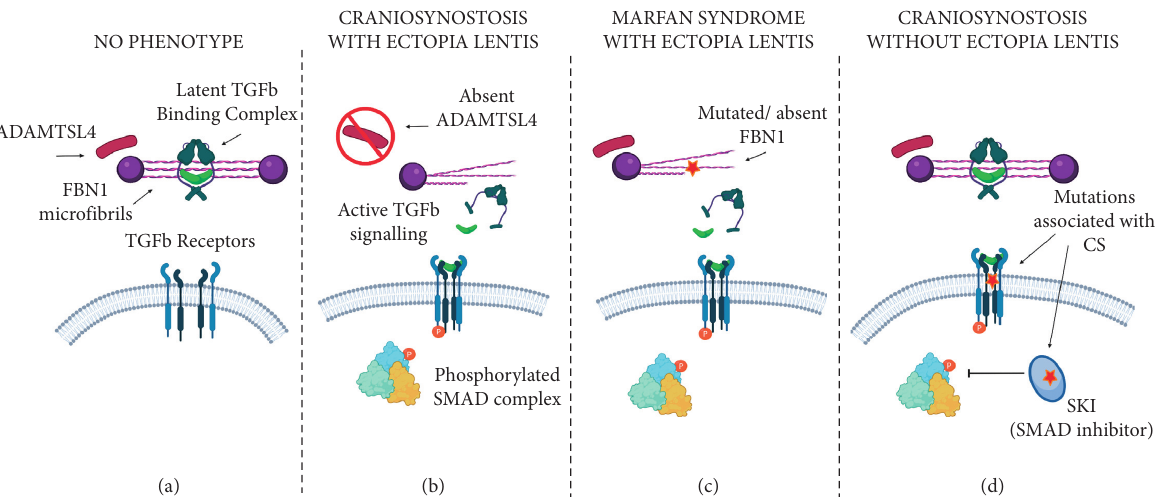
Figure 2: Schematic of proposed molecular mechanism of craniosynostosis and ectopia lentis phenotypes associated with ADAMTSL4, FBN1, and the TGFb pathway. (a) ADAMTSL4 is present and FBN1 is intact, TGFb ligand is tethered to fibrillin microfibrils, and the TGFb pathway is inactive. This does not cause a dysmorphic phenotype. (b) ADAMTSL4 is absent, fibrillin microfibrils are disintegrated leading to ectopia lentis, TGFb ligand is inappropriately released from extracellular matrix and binds TGFb receptors, and the TGFb pathway is aberrantly activated resulting in craniosynostosis. (c) ADAMTSL4 is present, but FBN1 is mutated, fibrillin microfibrils are disintegrated, TGFb ligand is inappropriately released from extracellular matrix and binds TGFb receptors, and the TGFb pathway is aberrantly activated resulting in Marfan syndrome with ectopia lentis. (d) ADAMTSL4 is present and fibrillin microfibrils are intact. Activating mutations in TGFb receptors and downstream modulators of the TGFb pathway cause aberrant signaling resulting in syndromic craniosynostosis (LDS/SGS) without ectopia lentis. (created with